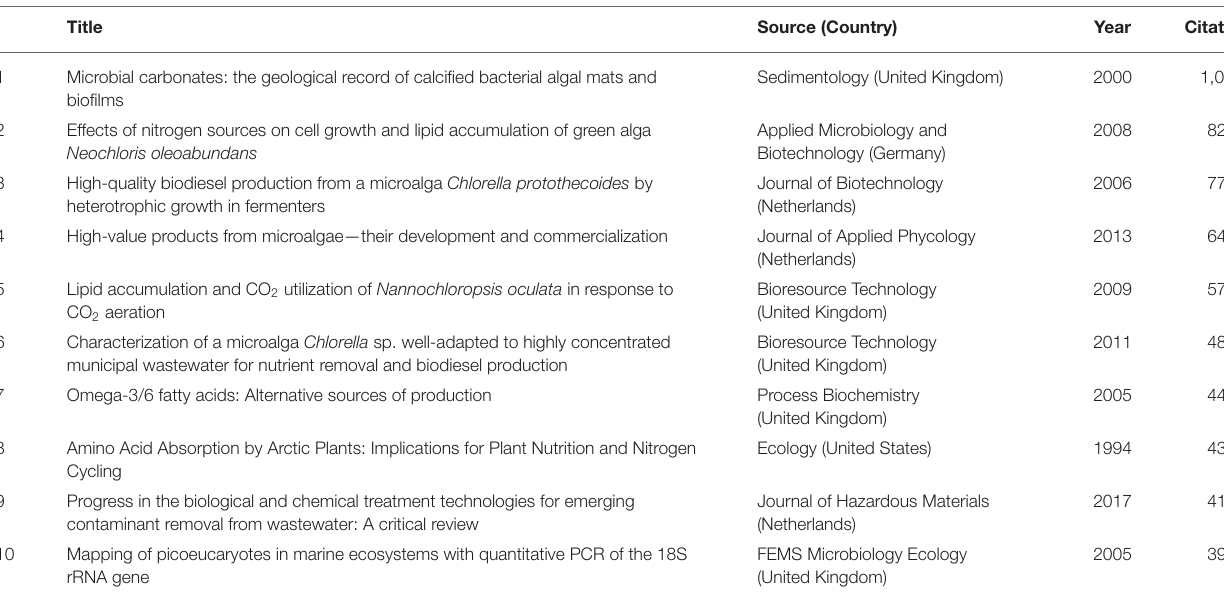
Sedimentology (United Kingdom) 2000 1,035